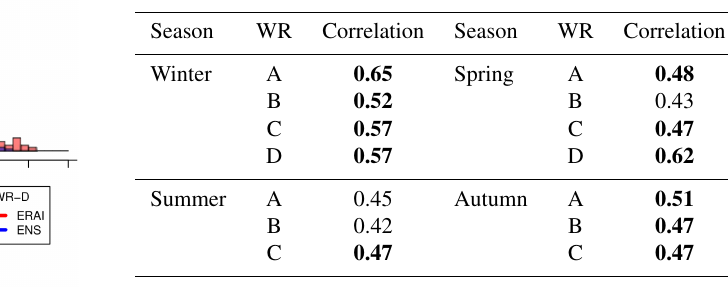
Table 4. Correlation values between the forecasted and observed MOAWR for each WR and the four seasons. Values indicated in bold have a significance level above